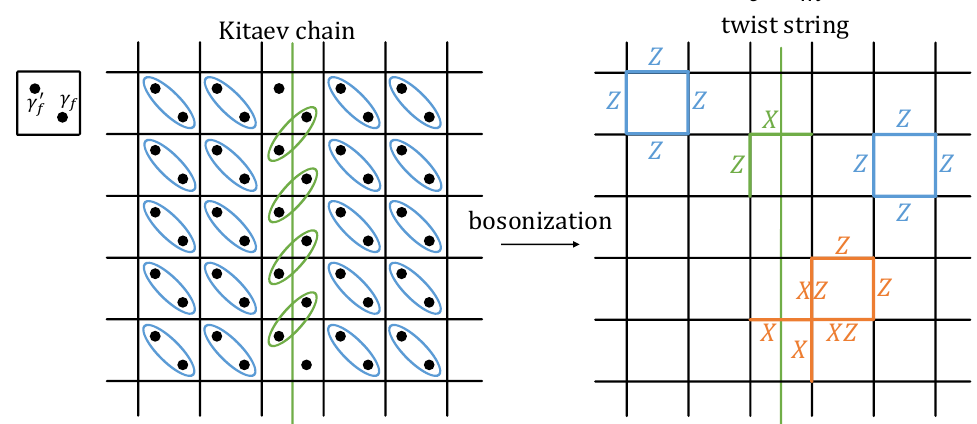
Figure 9: Left: each dot represents a Majorana fermion. The Kitaev chain is decorated on the green line, which makes the Majorana fermion paired with the other one on its adjacent face; otherwise, Majorana fermions are paired within each face and form an atomic insulator. Right: after bosonization, the pairing term on the Kitaev chain becomes the hopping operator U on the twist string, while the pairing term in each e face not on the Kitaev chain becomes the Z fluxes. Note that the gauge constraint = 1 holds at all G v